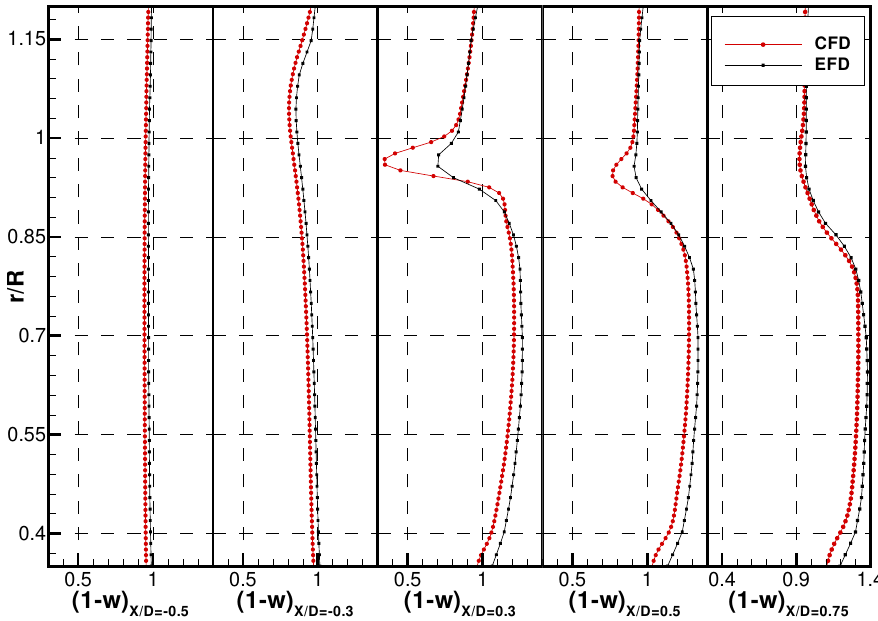
Figure 15. Circumferential axial velocity average for the ducted configuration.